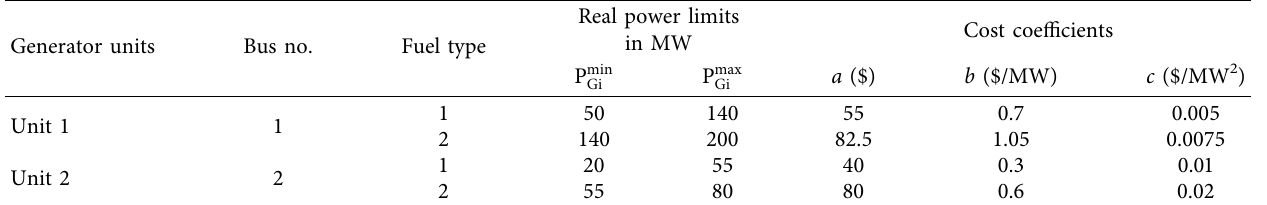
Table 8: Cost coefcients of generator units 1 and 2 for the IEEE 30-bus system when considering two fuels types. Generator units Bus